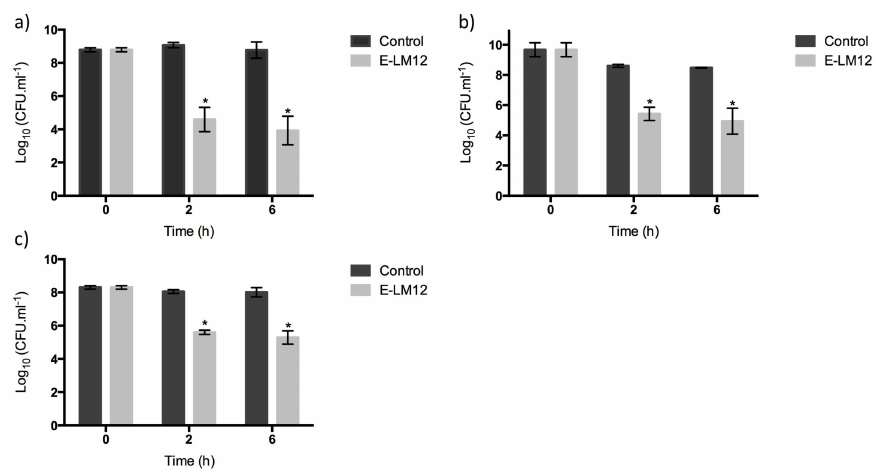
Figure 5. Endolysin E-LM12 activity against 24 h S. aureus planktonic cells, using 8 µ M ( a ) exponential phase cells, ( b ) stationary phase cells, and ( c ) biofilm suspended cells. Data was assessed by CFU counting, and the values represent the mean (plus or minus) of three independent experiments performed in duplicate. Statistical differences ( p < 0.01) between control biofilms and LM12-treated biofilms (*) were determined by two-way repeated-measures analysis of variance (ANOVA) with a Sidak